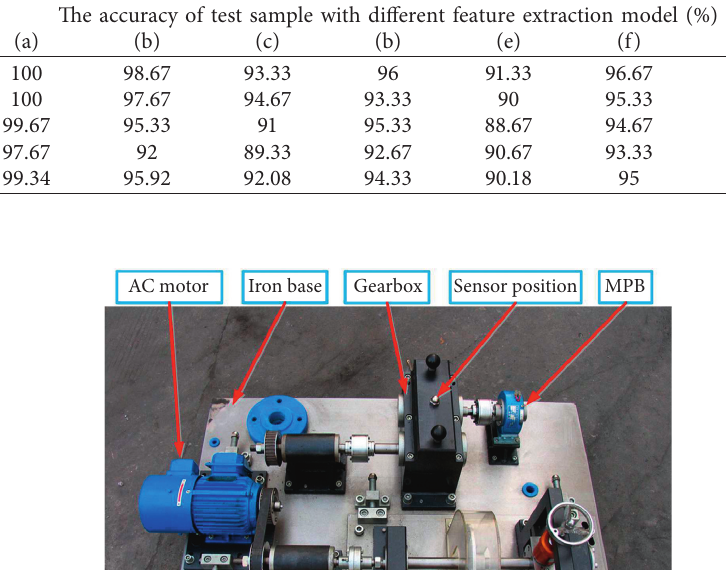
Table 3: The diagnostic results obtained by combining seven models with four classifiers.